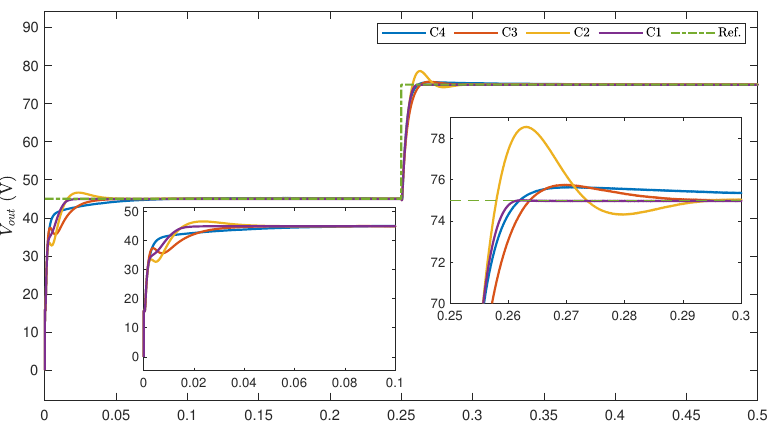
Figure 3. The output voltages of the FIBC under the four controllers in case of step voltage refer- ence